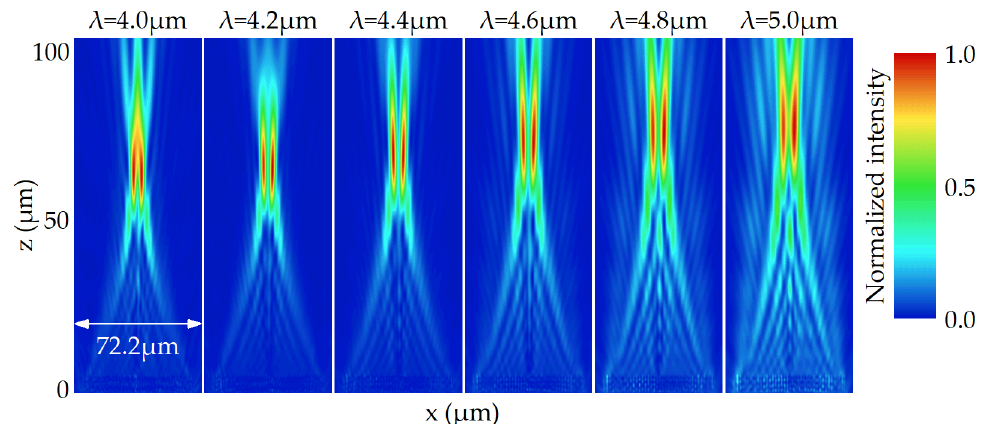
Figure 6. The simulated electric field intensity on the x-z plane for the FVBG with positive dispersion between 4.0 and 5.0 μ m.